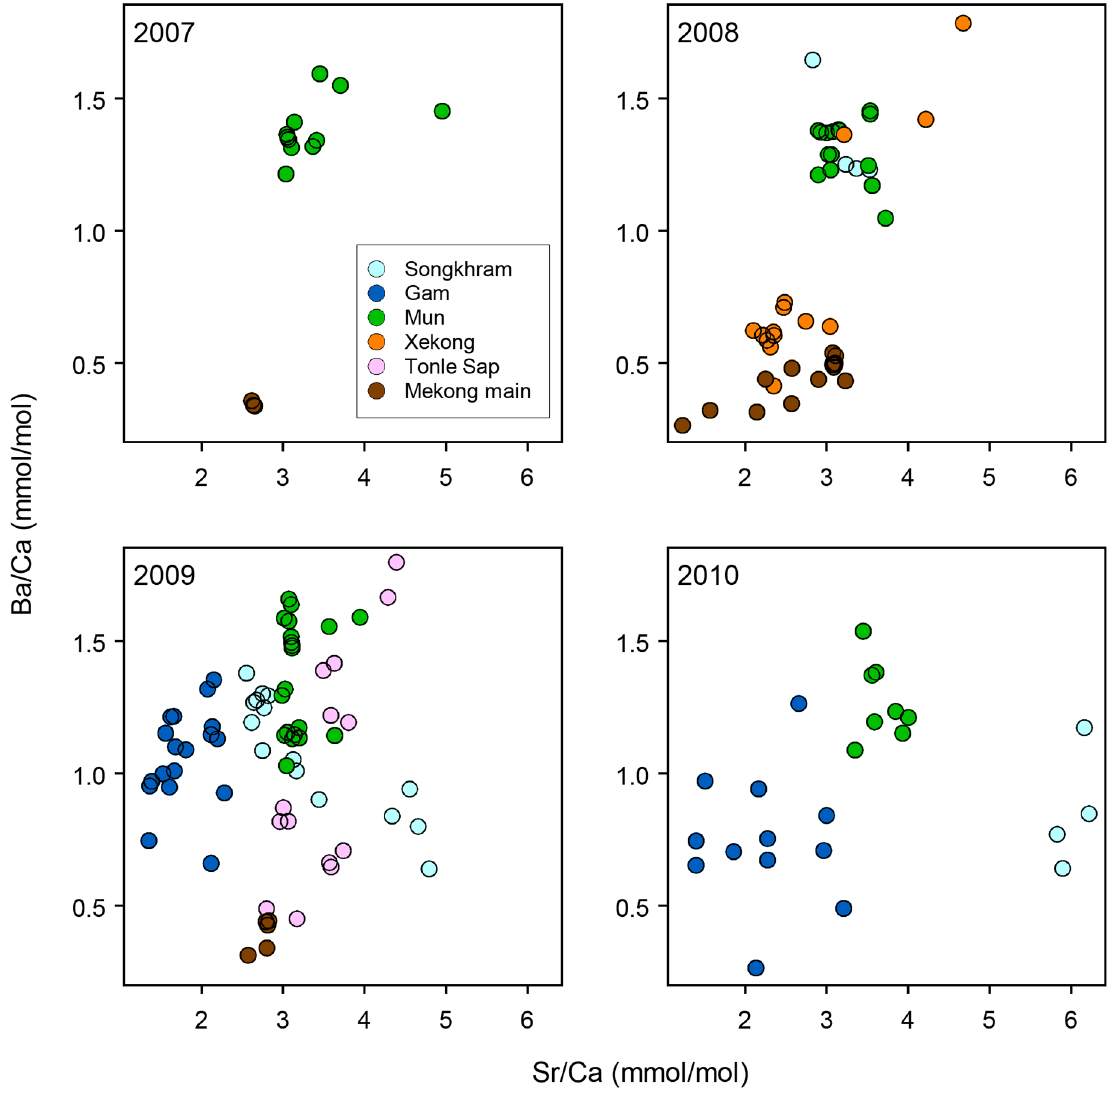
Figure 3. Sr-Ba elemental signatures of river water samples collected from six regions during 2007-2010.